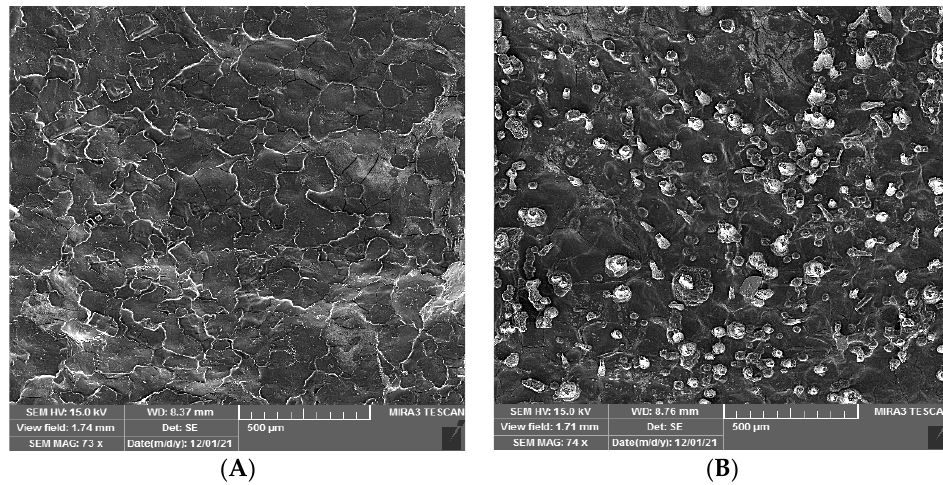
Figure 8. Surface morphology of ( A ). Pure hydrogel with uniform and smooth surface, ( B ). Phage - containing hydrogel with protrusion surface.